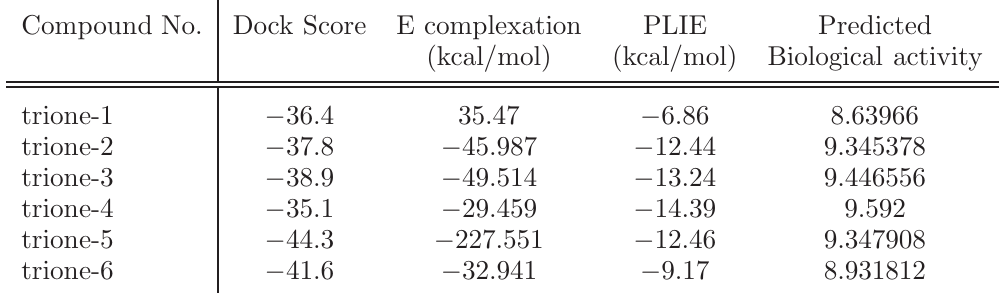
Table 4 Dock Score, complexation energy, protein ligand interaction energy and predicted biological activity of new cyclic urea